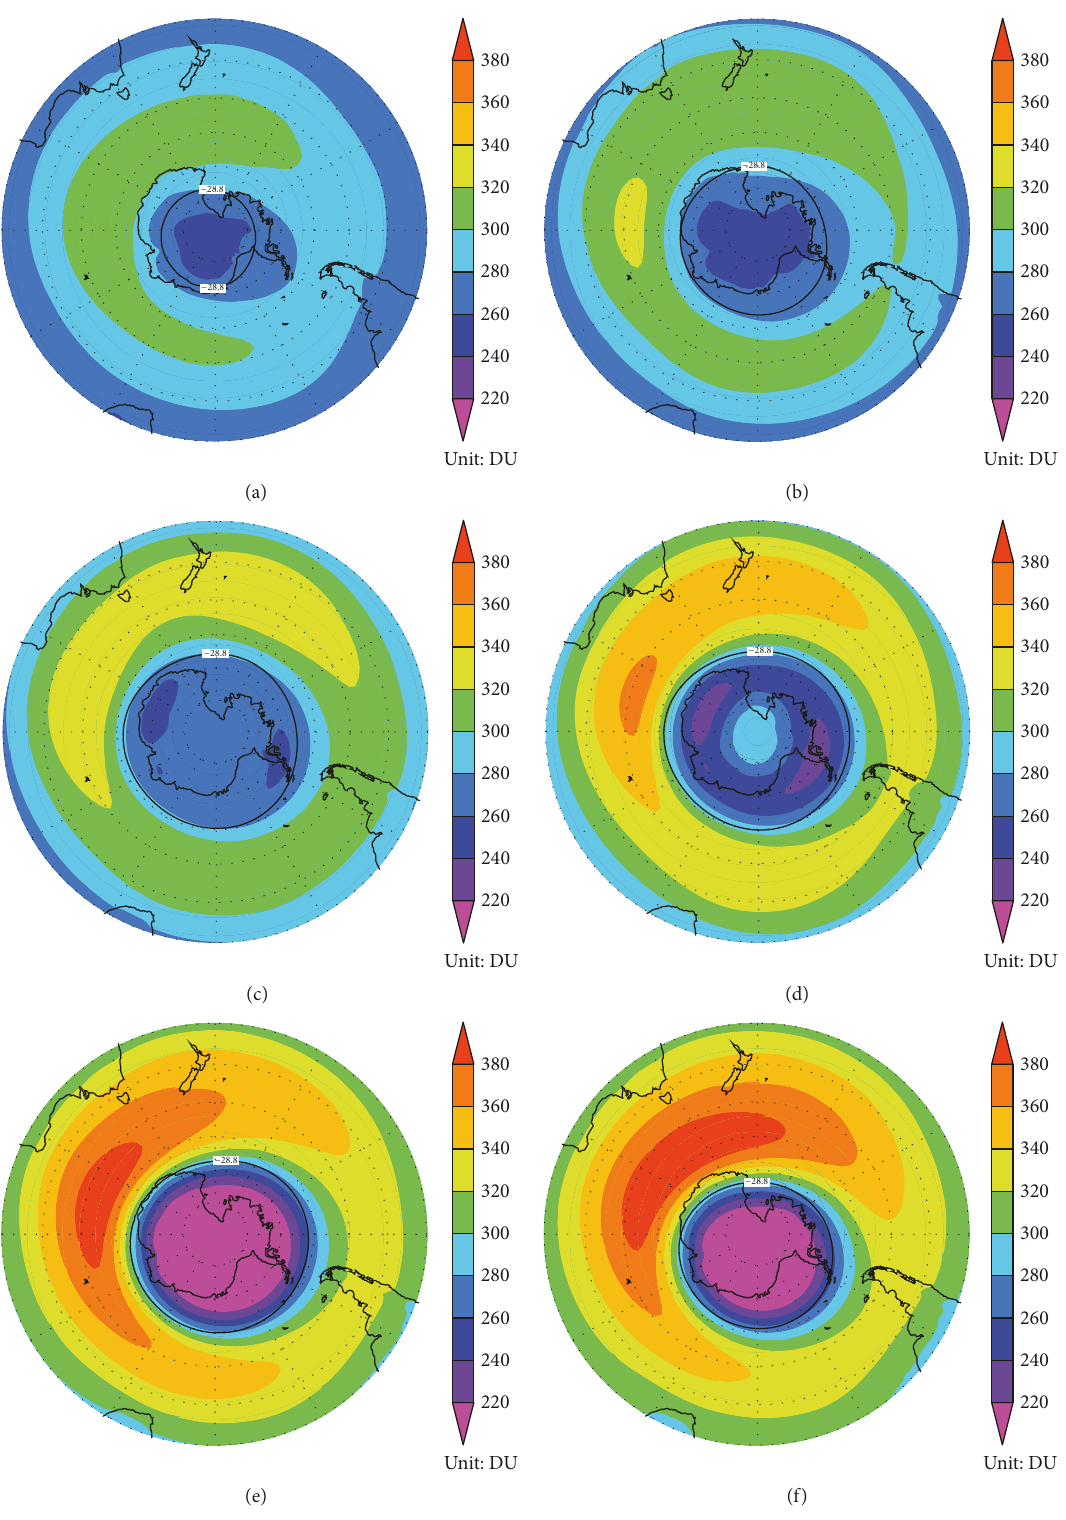
Figure 3: Spatial distributions of the 38-year (1979–2016) total column ozone (units: DU) in (a) May, (b) June, (c) July, (d) August, (e) September, and (f) October. The black solid based on criterion PV contour ( − 28.8 PVU) represents the vortex